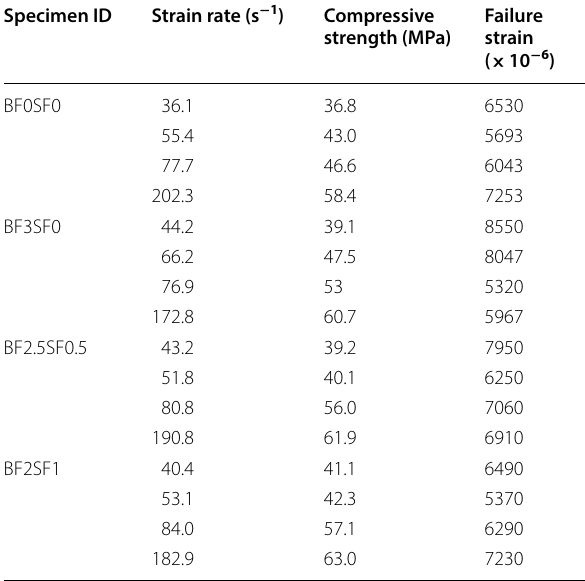
Table 5 Dynamic compressive performances of various